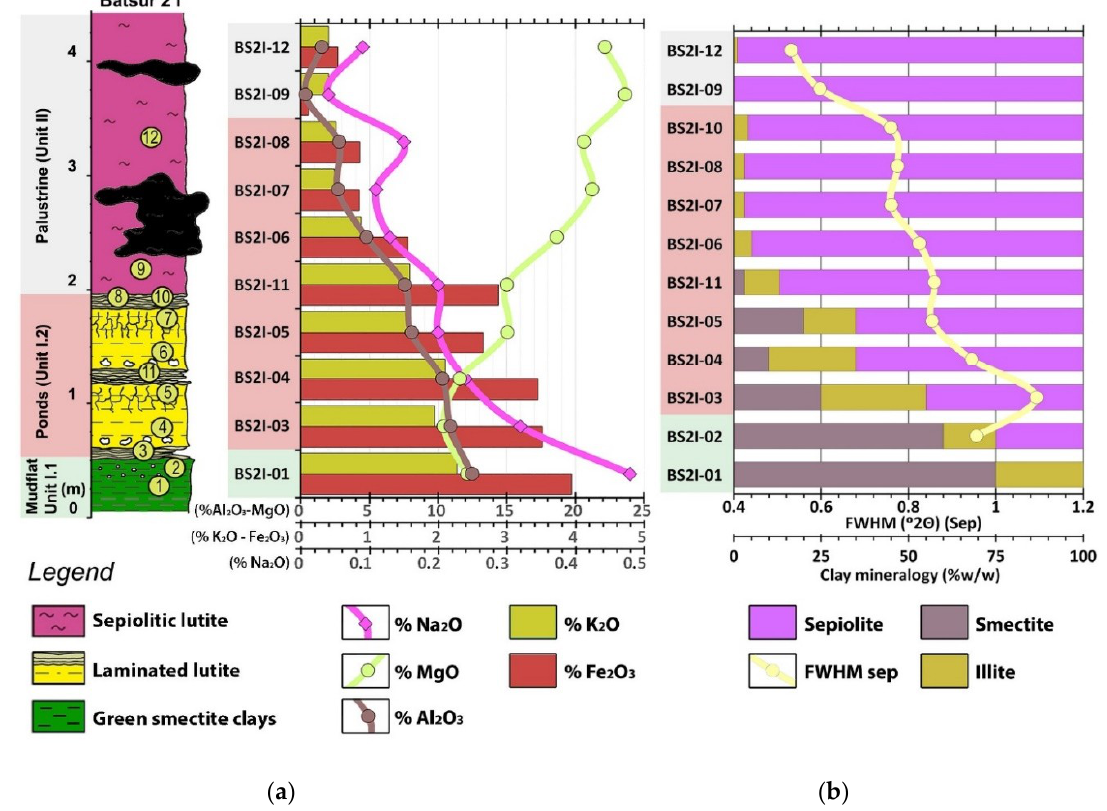
Figure 12. ( a ) Lithostratigraphic log of BS2I showing the variation in the content of selected major elements; and ( b ) clay mineralogy and FWHM variation of sepiolite.